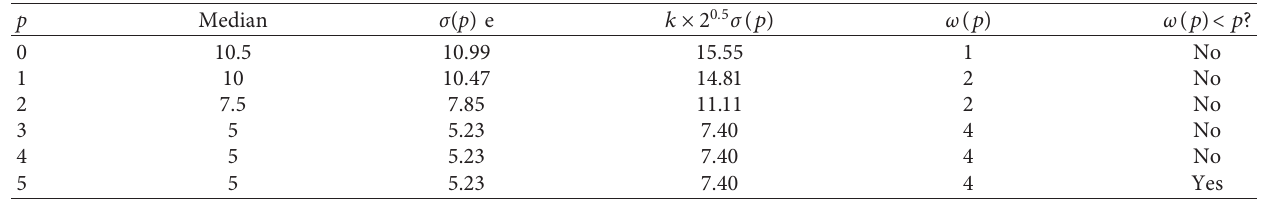
Table 20: step estimations for the investigation with the edge